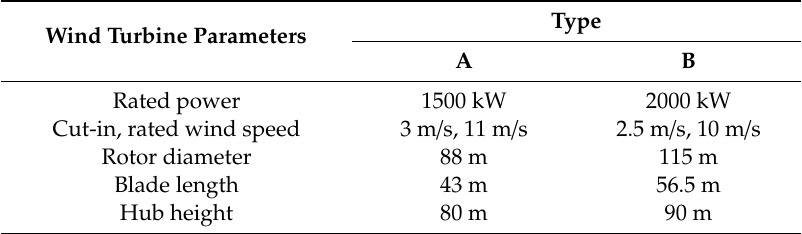
Table 1. Specification of two types of wind turbines.